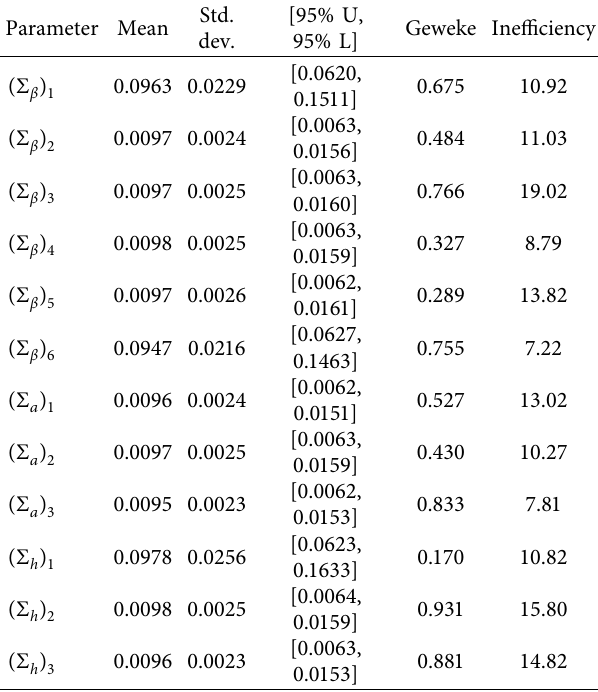
Table 10: Parameter estimation and test of TVP-SV-VAR